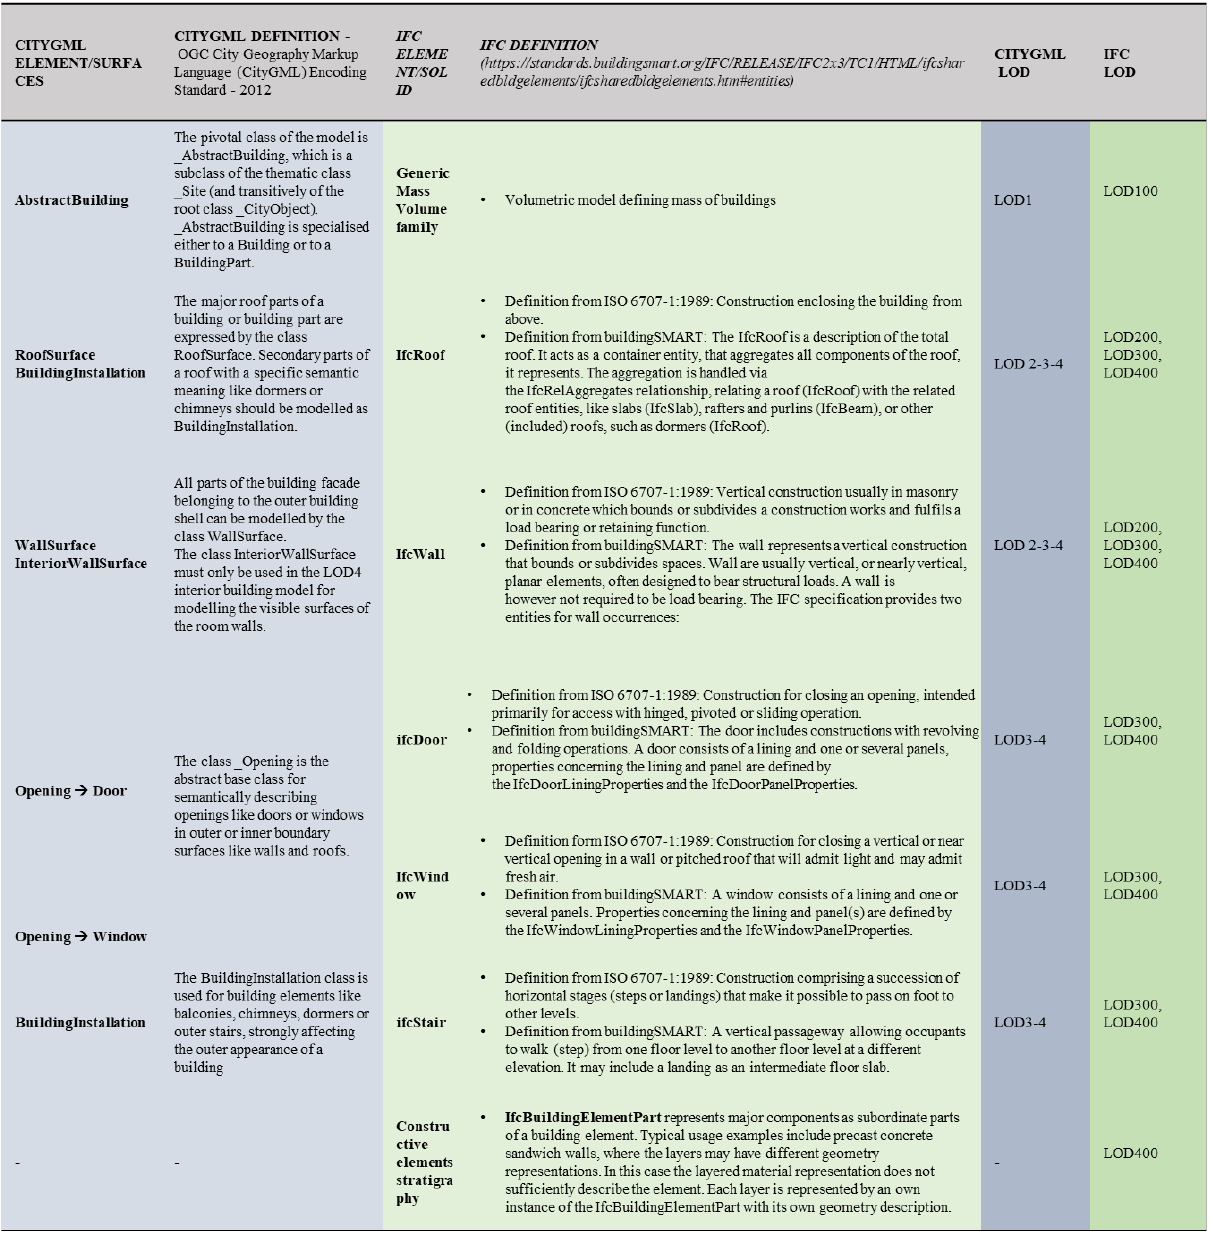
Table 2. Existing similarities in the comparison of CityGML elements description and IFC objects definitions. We can notice a correspondence between the two different standards’ LODs. Hence, in our methodology, the model designed according to IFC BIM has link/connection in the visualisation and in the scale of representation that could be noticed in the integration of the HBIM model in